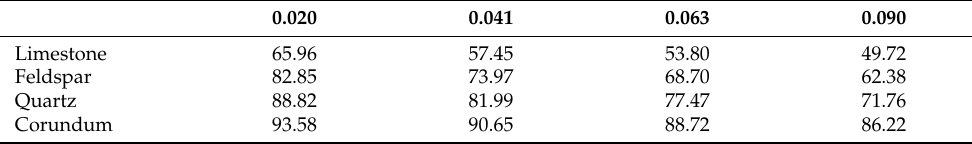
Table 10. Laser granulometry analysis of materials after grinding, over sieve (%).